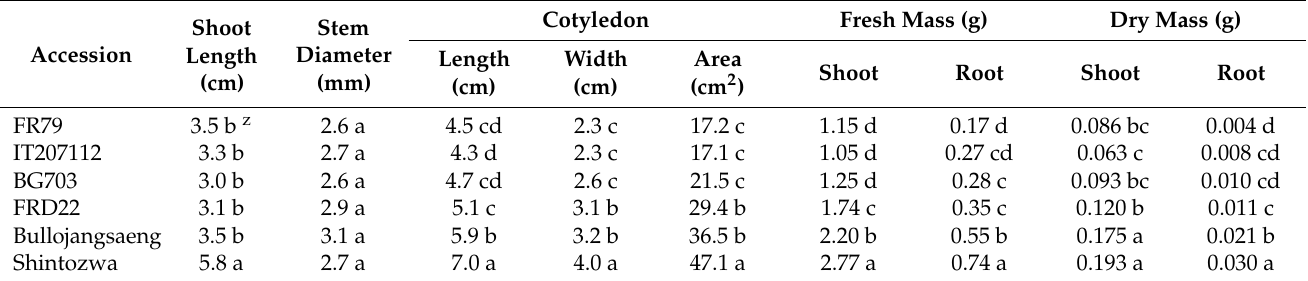
Figure 4. The seeds and seedlings of Lagenaria accessions at seven days after sowing. Table 2. The growth of bottle gourd rootstock accessions at 11 days after sowing in semi- forcing